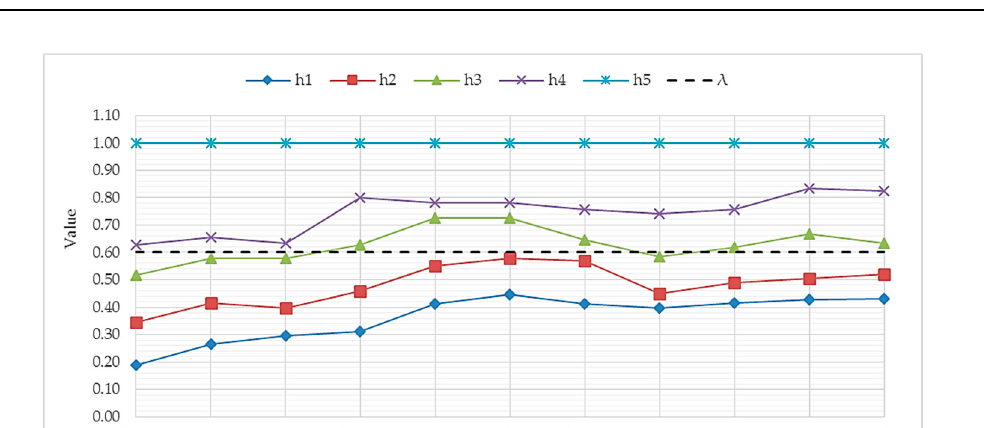
Table 5. Total connection degree and cumulative connection degree of PSR subsystems of water resources security.